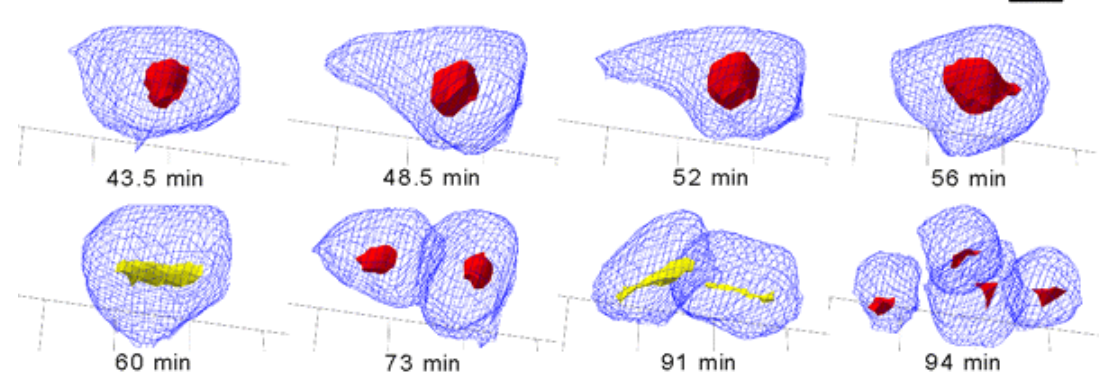
FIGURE 10. 3D-DIASemb allows presentation of single cell lineages, in this case the C-cell lineage between 43.5 and 94 min. Note the cellular extension between 48.5 and 52 min. Interphase nuclei are color-coded red and mitosing nuclei yellow (see [54] for